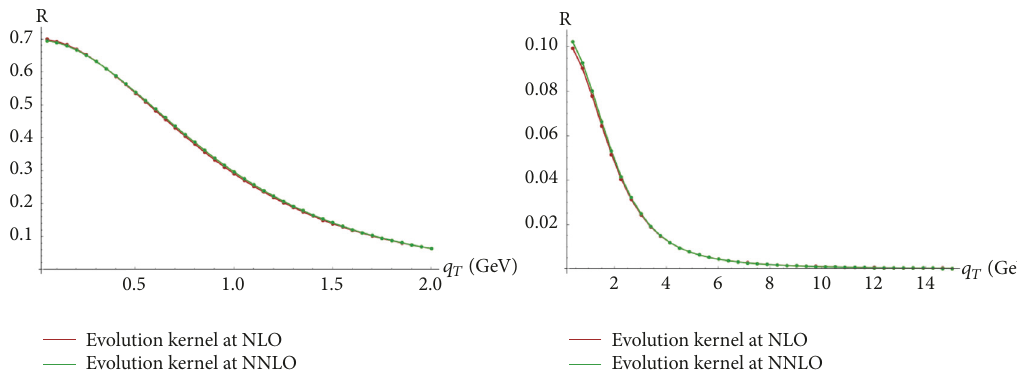
Figure 3: 𝑅 evolution factor using the optimal TMD prescriptions when the high scale is fixed at the Z-boson mass (right side) and at BELLE center of mass energy 10.52 GeV (left side). In this figure one has chosen 𝑏 푚푎푥 = 2.5 GeV −1 and D 푁푃 = exp (−𝑔 퐾 𝑏 푇2 ) with 𝑔 퐾 = 0.1 GeV 2